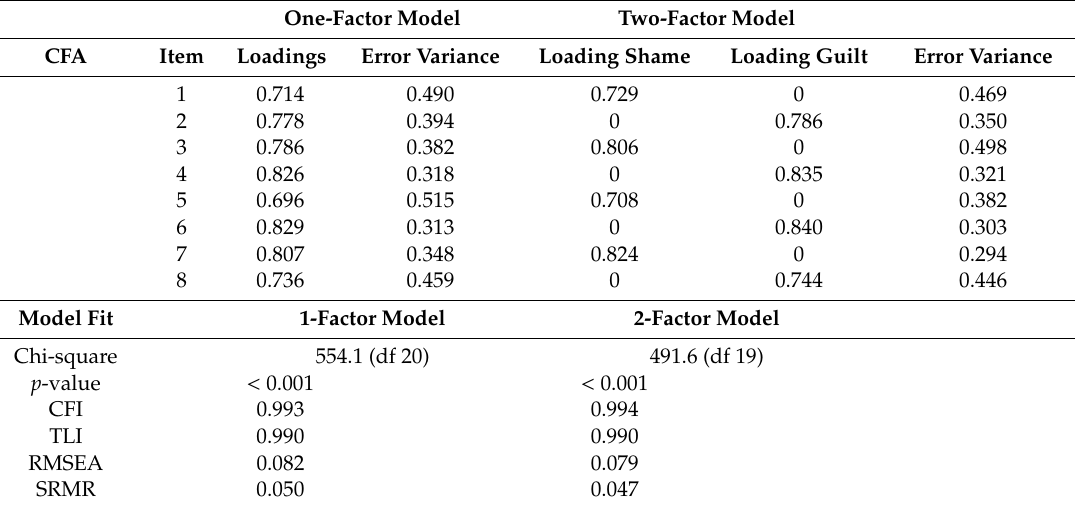
Table 5. Parameters of the confirmatory factor analysis, the one- and two-factor models of the GSES